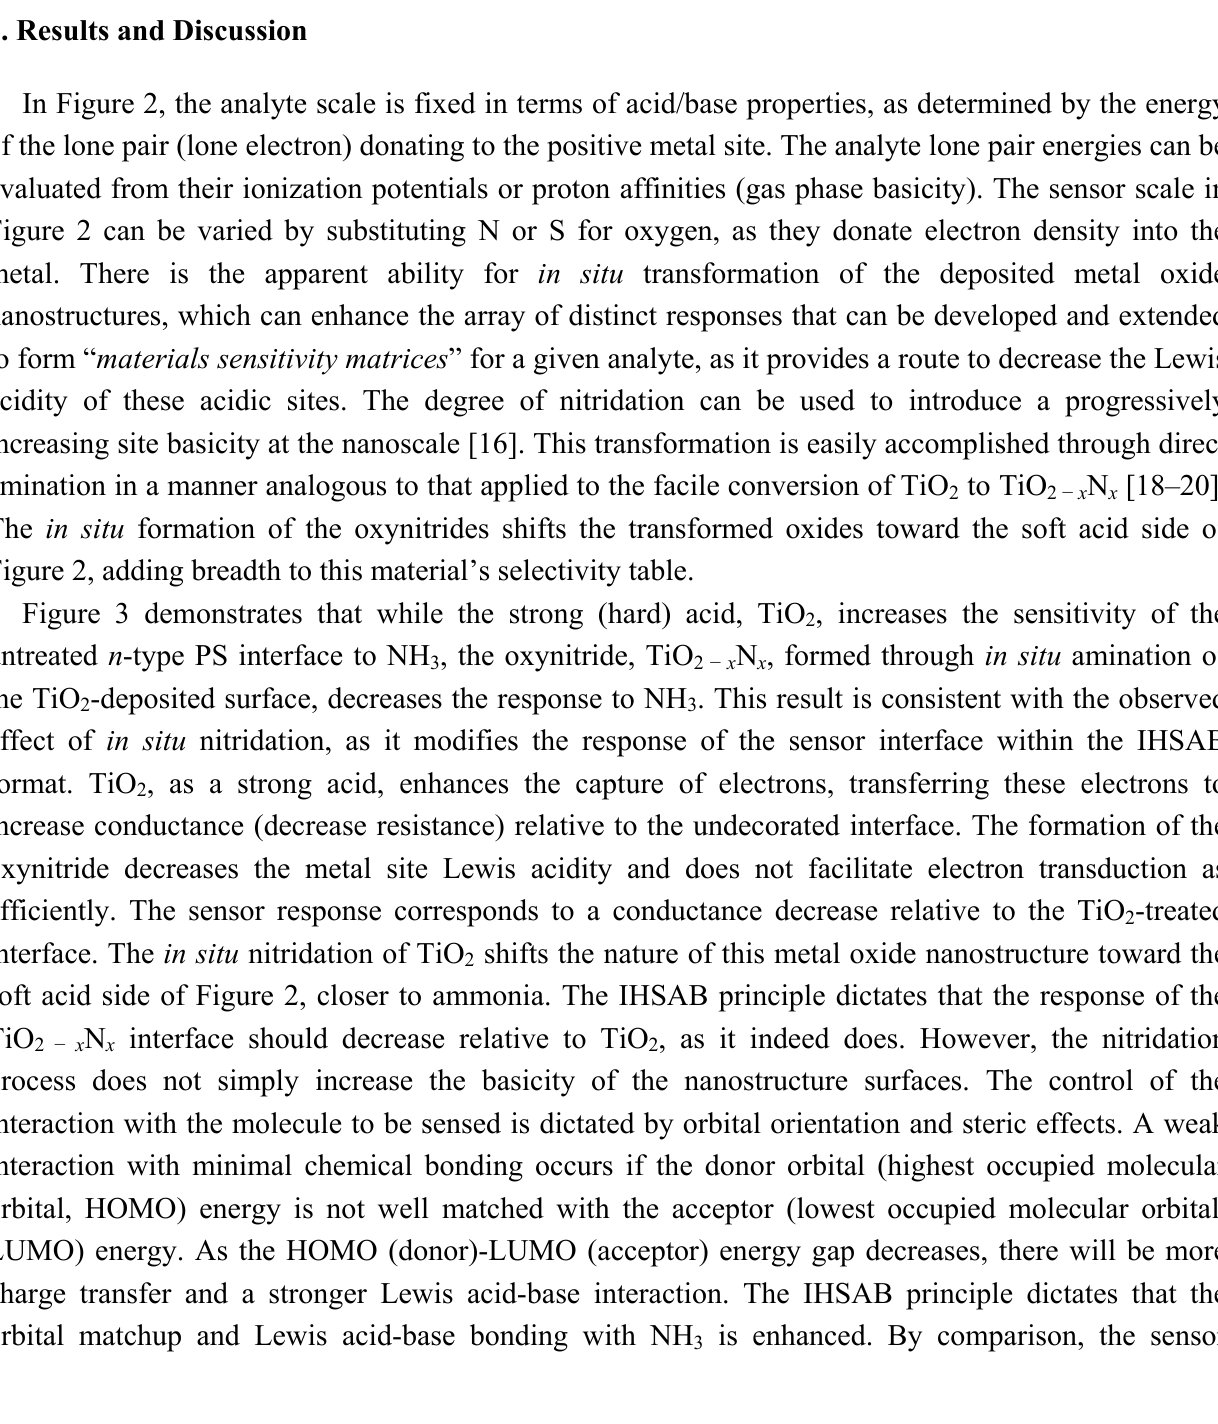
as summarized in the 3 and NO, shown in 3